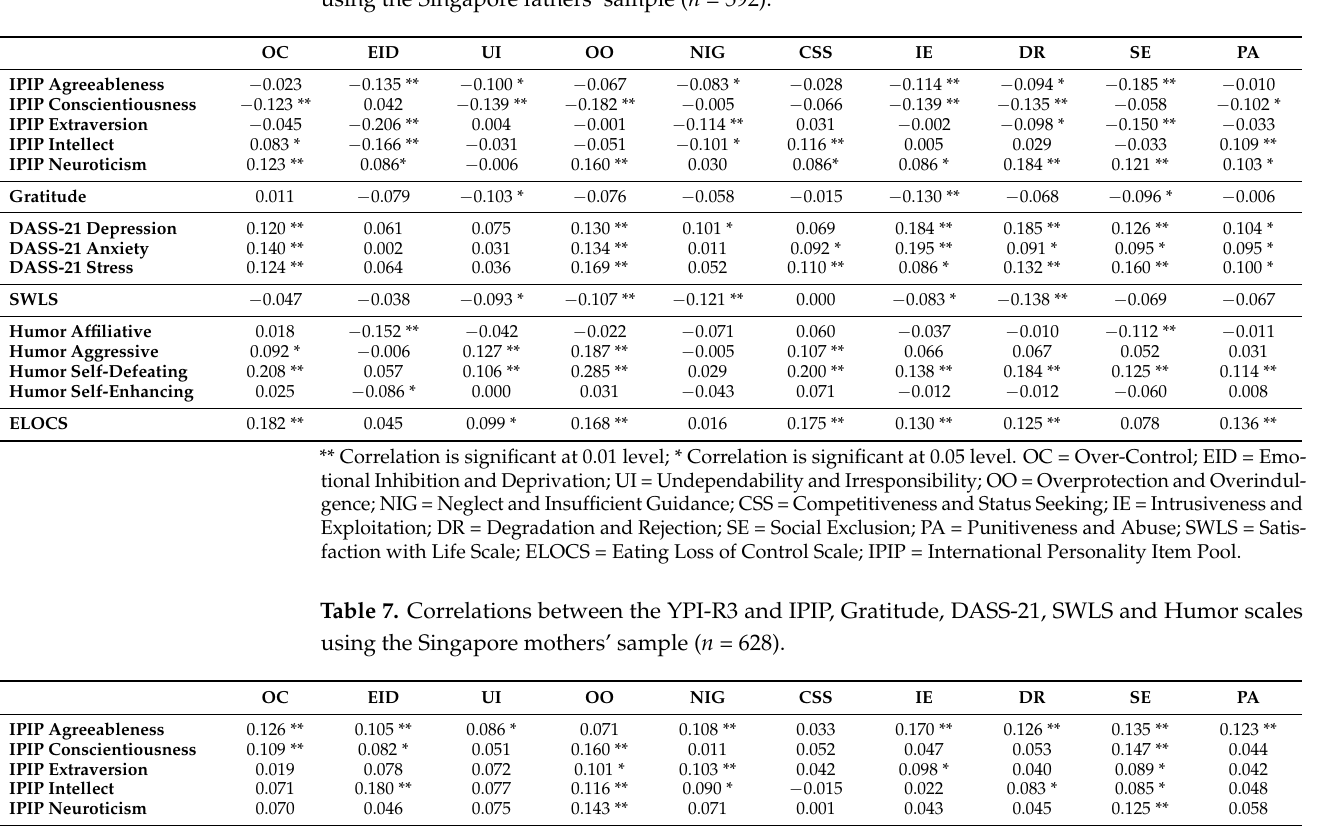
Table 6. Correlations between the YPI-R3 and IPIP, Gratitude, DASS-21, SWLS and Humor scales using the Singapore fathers’ sample ( n = 592).